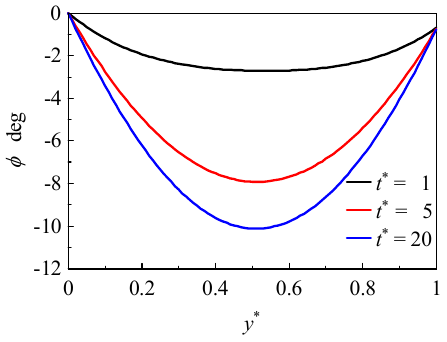
Fig.9 Director angle profiles for Er=25 and